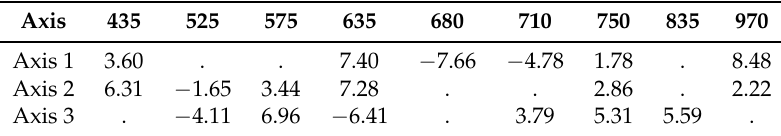
Figure 7. Non-metric multidimensional scaling (NMS) ordination results using band depth values from Lake Arnold (LA), northeast boundary (NEB), northeast early (NEE), and southwest early (SWE) fields at the Blandy Experimental Farm in northern Virginia for ( a ) axes 1 and 2; ( b ) axes 1 and 3; and ( c ) axes 2 and 3. Table 3. Multiple regression coefficients, assessing which wavelengths most influence non-metric multidimensional scaling (NMS) ordination